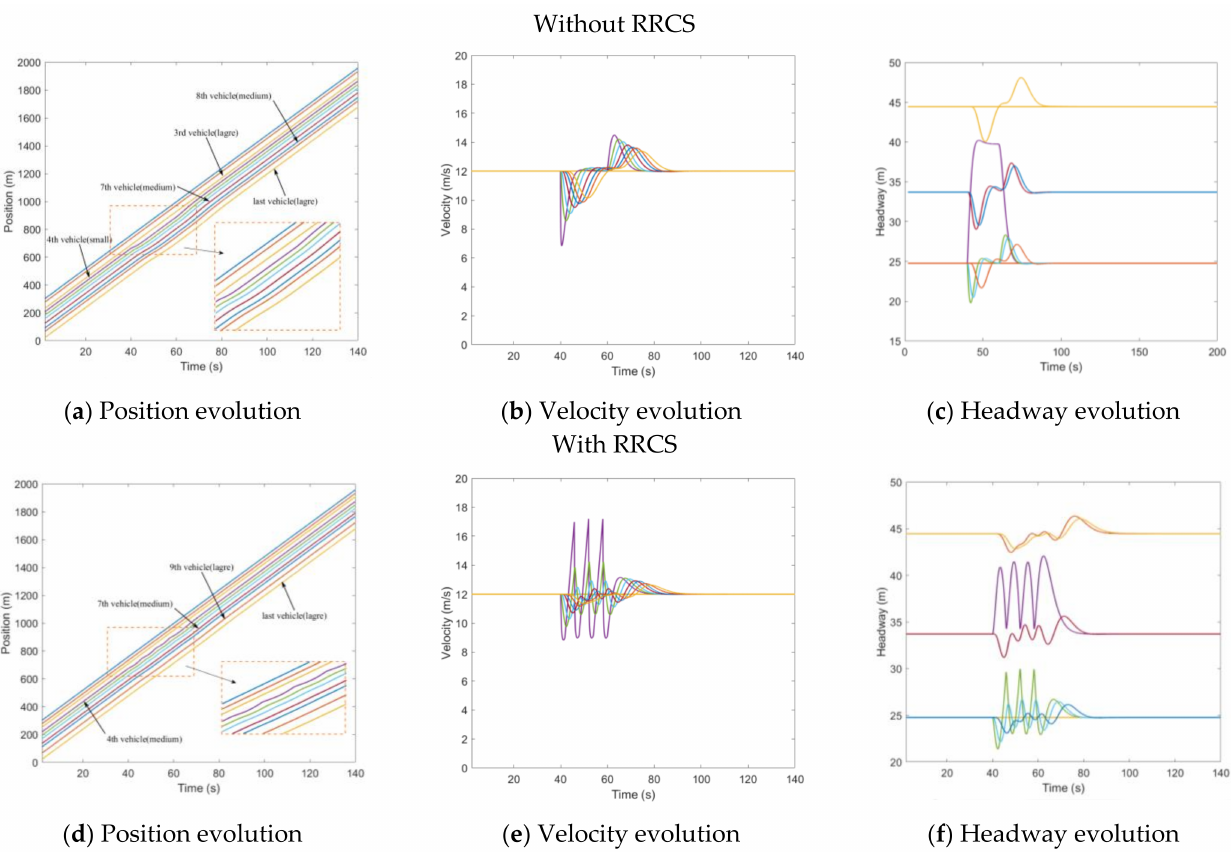
Figure 6. Mixed traffic flow evolution diagrams under the underestimated position with/without